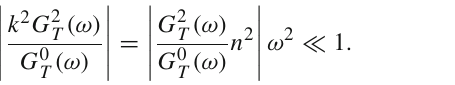
atures T = 0 . 81 T c (left) and T = 0 . 86 T c (right) for